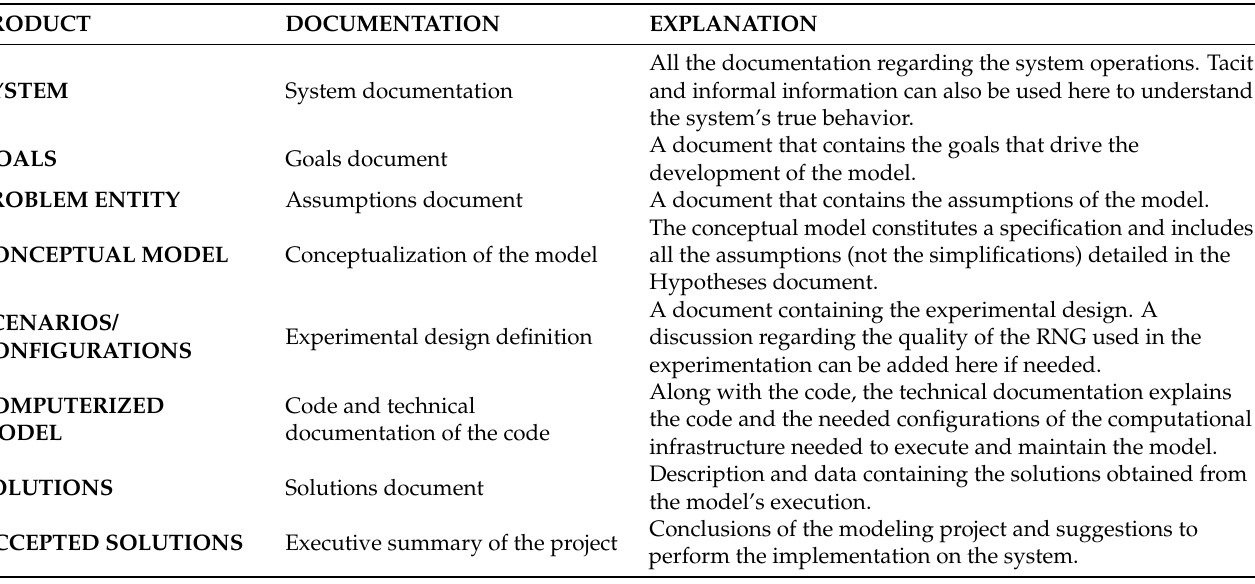
Table 1. Proposed documents were obtained in each product of the modeling